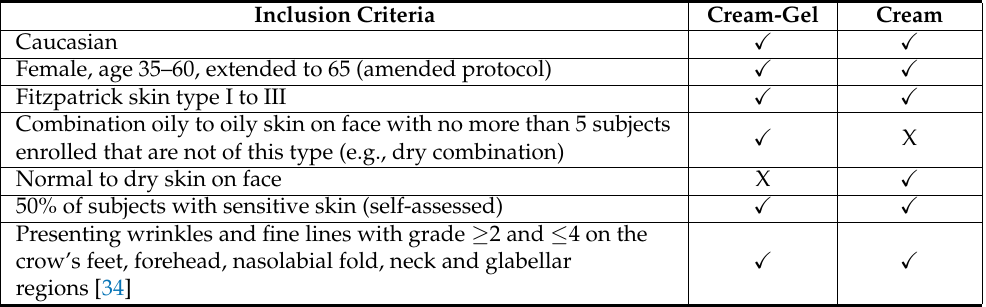
Table 1. Inclusion criteria of the observational clinical studies. Check Marks (cid:88) means yes, and X means no. The selection criteria were the same for both test formulations, except the difference of recruiting normal to dry skin for cream testing and combination oily to oily skin for cream-gel testing. Inclusion Criteria Cream-Gel Cream Caucasian